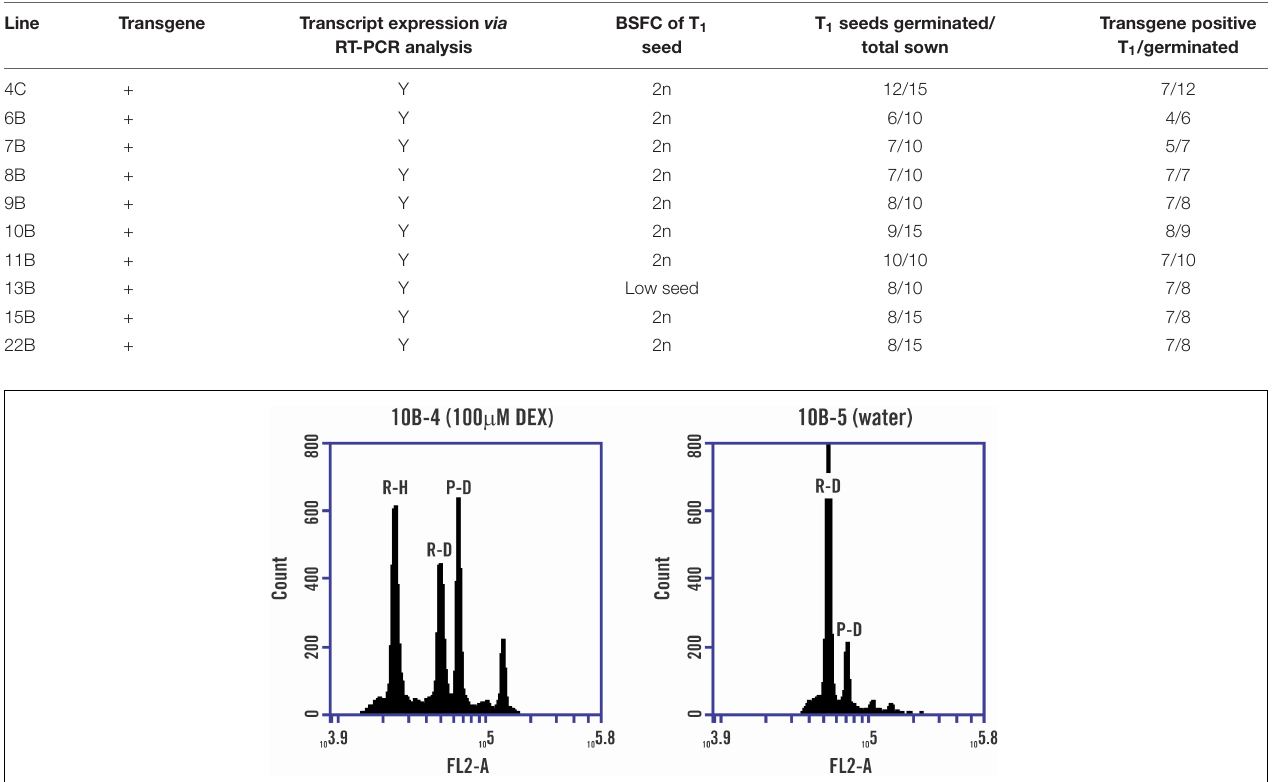
TABLE 1 | Characterization of AtDD45::PsASGR-BBML:GR T 0 lines used in DEX induction studies. Line